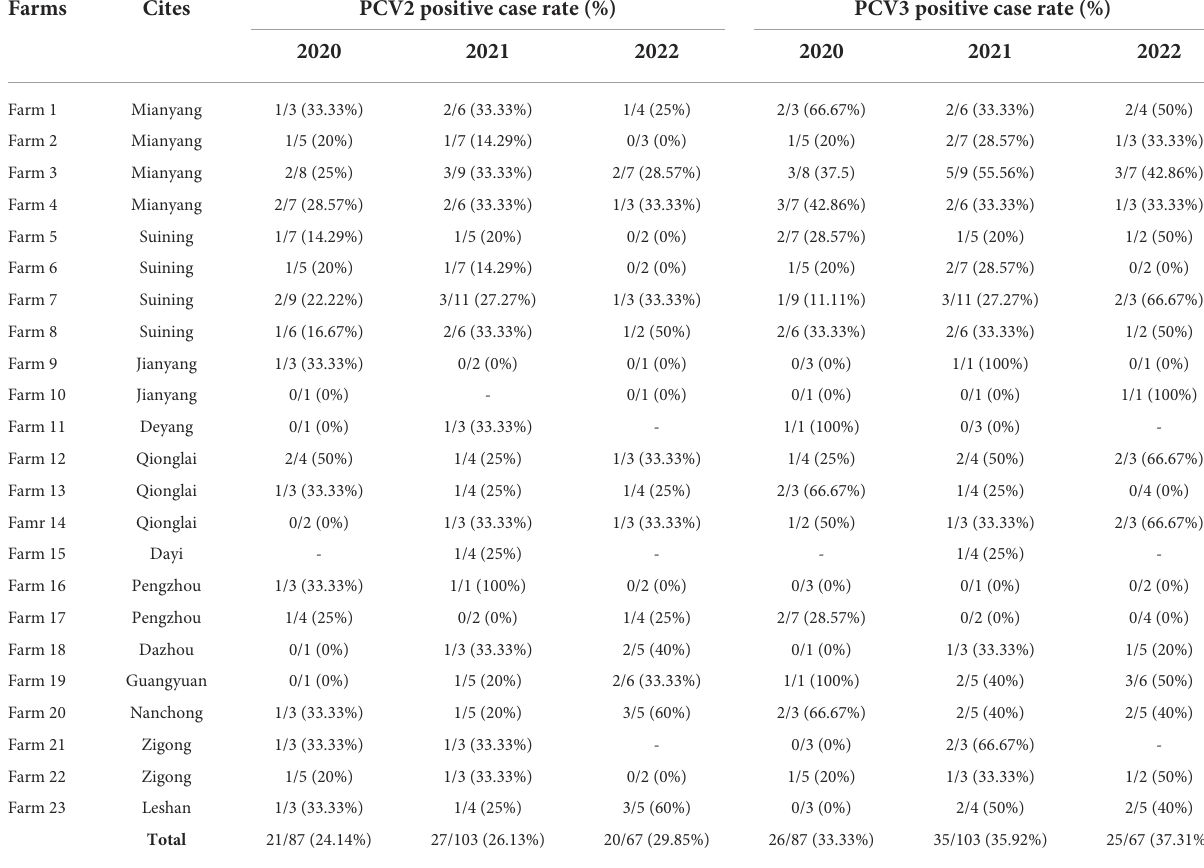
TABLE 2 The prevalence rates of PCV2 and PCV3 in different cities in the Southwest of China during 2020–2022.